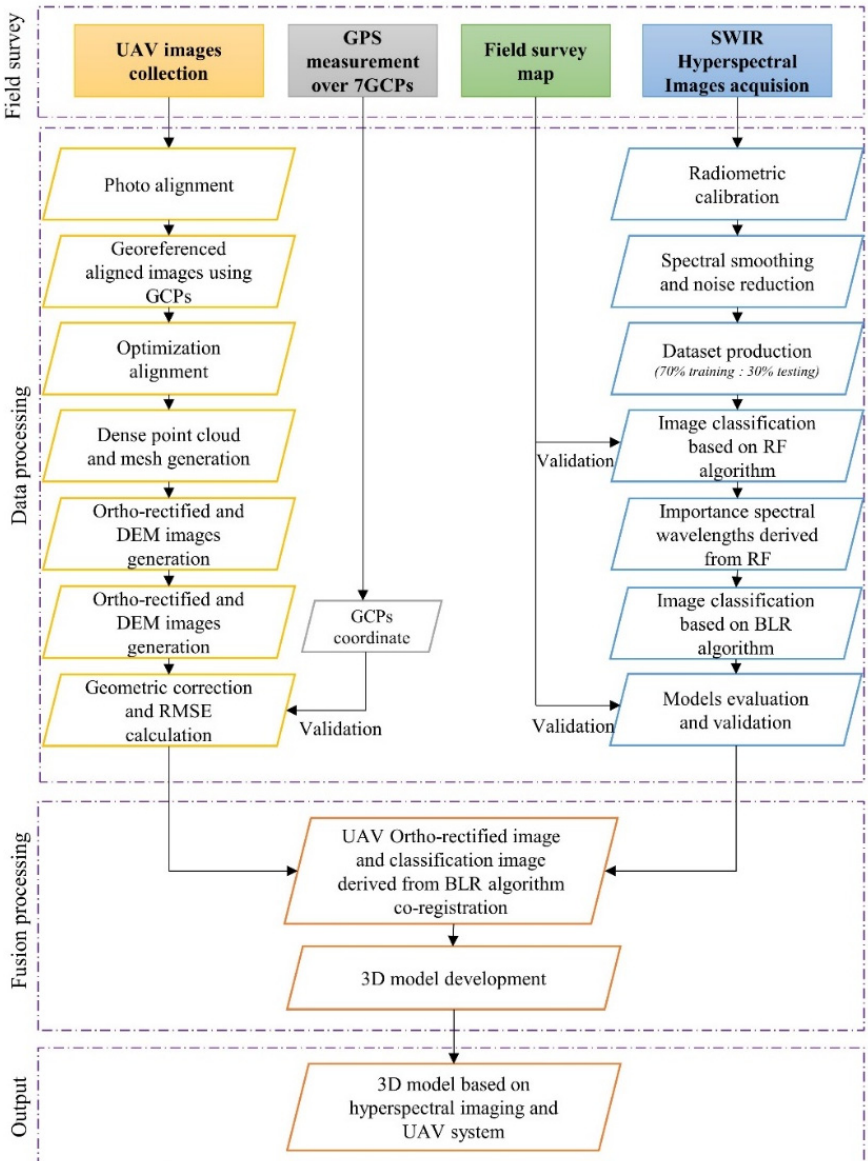
Figure 4. Methodology diagram in this study.